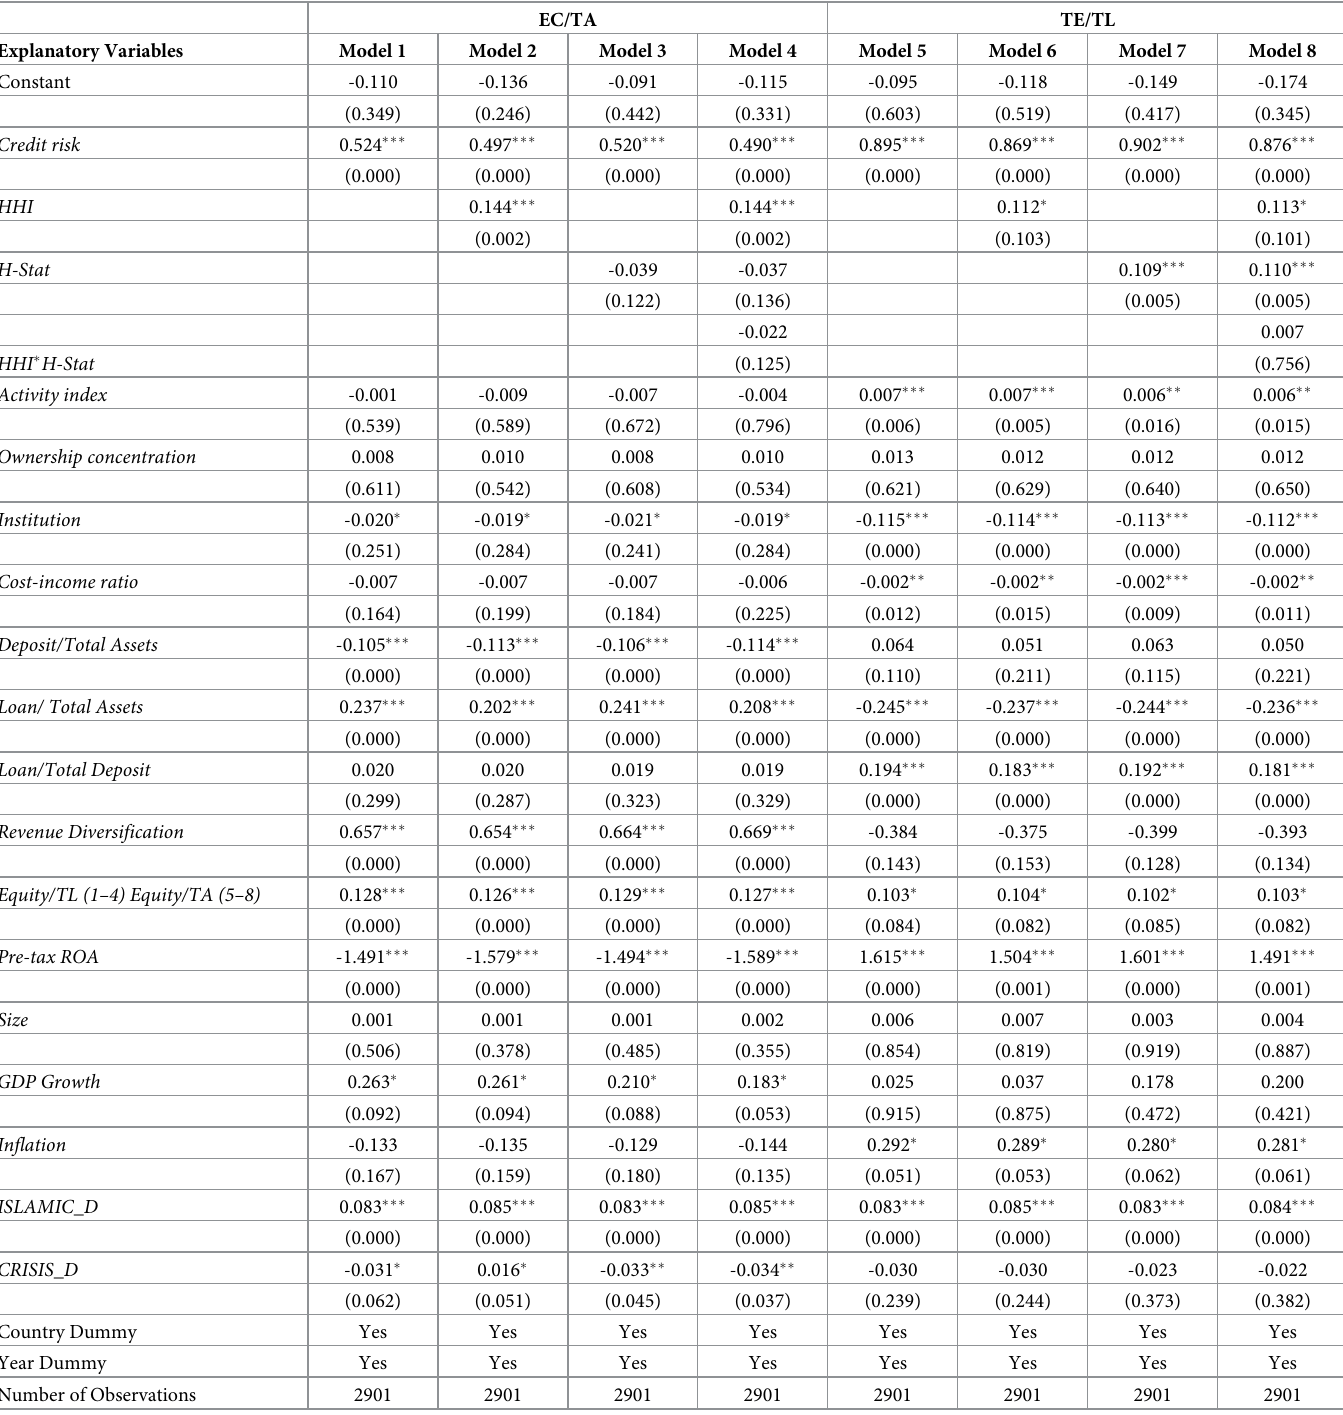
Table 3. Panel regressions of competition and capital ratio (all banks,